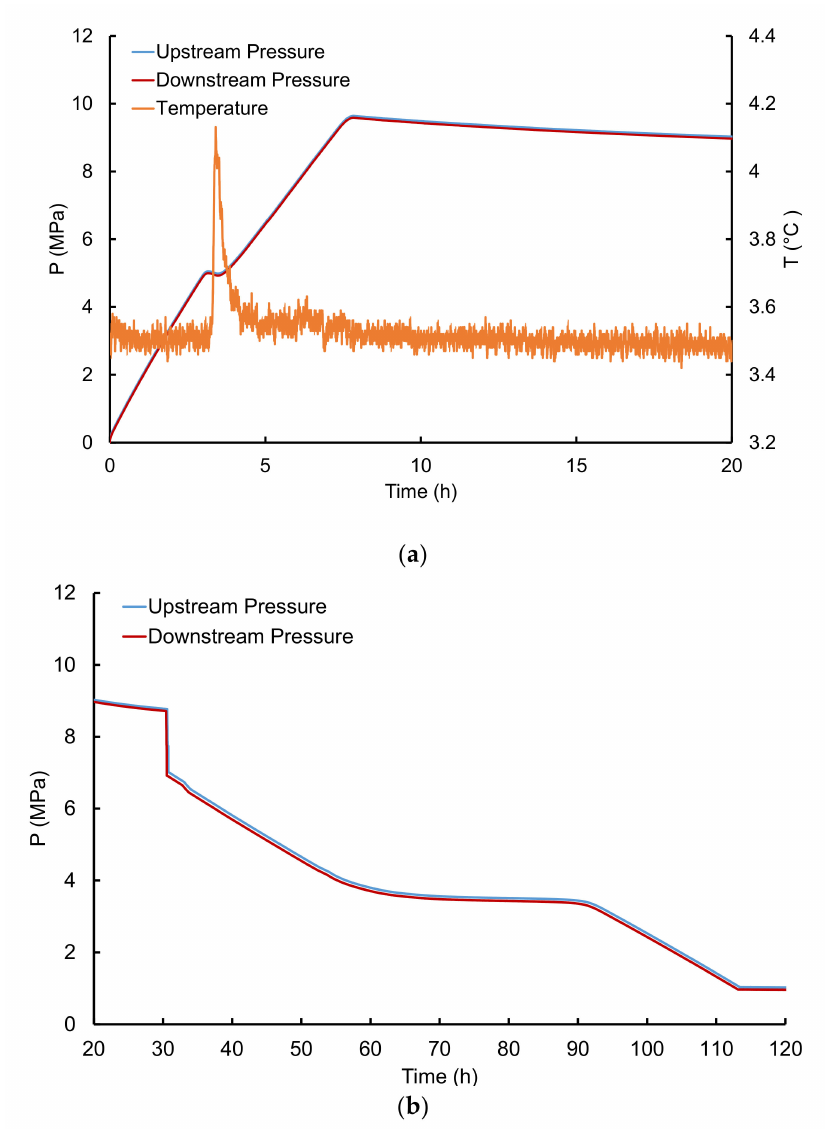
Figure 3. Evolution of upstream and downstream pressures with time. During ( a ) the formation and ( b ) depressurization step. The pressure in the cell decreases gradually during depressurization due to the release of free methane. The sudden drop observed in ( b ) at around 30 h is likely due to the breaking or dissociation of a hydrate plug that, at some point during the hydrate formation step, isolated a volume of the core from the remaining and hindering the gas to further accumulate. Thus, their reconnection after the dissociation of the plug leads to a pressure drop and equilibration. When the system reaches the H-L-V equilibrium pressure, hydrates begin to dissociate and release the methane previously stored. The pressure in the cell remains practically constant during hydrate dissociation. The procedure used for the quantification of hydrate-bound methane was developed by Ru ffi ne in a previous work. The di ff erence between hydrate formation pressure and hydrate dissociation pressure is detailed in Section